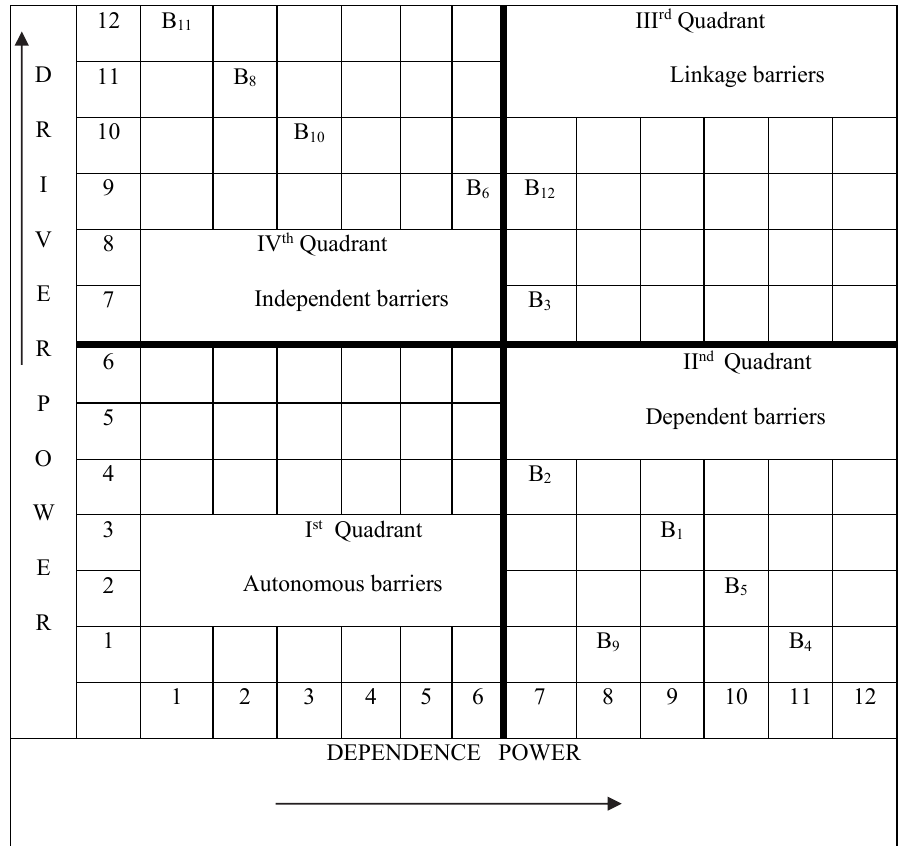
Fig. 4. Driver power-dependence